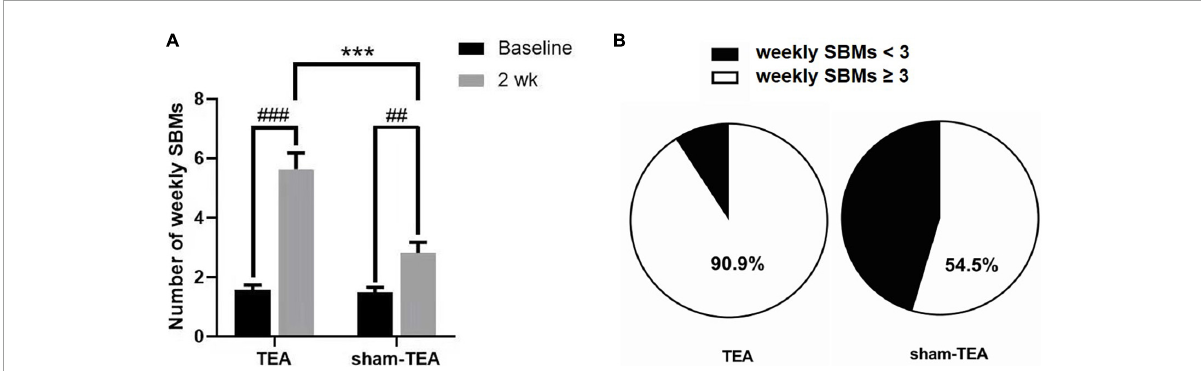
FIGURE1 Effects of TEA and sham-TEA on the weekly SBMs of patients with chronic constipation after 2 weeks’ treatment. (A) The mean weekly SBMs in the two groups before and after 2 weeks of treatment (vs. baseline, ## P < 0.01, ### P < 0.001; vs. sham-TEA, *** P < 0.001). (B) The proportion of patients with < 3 and ≥ 3 mean weekly SBMs after 2 weeks of treatment in the two groups.